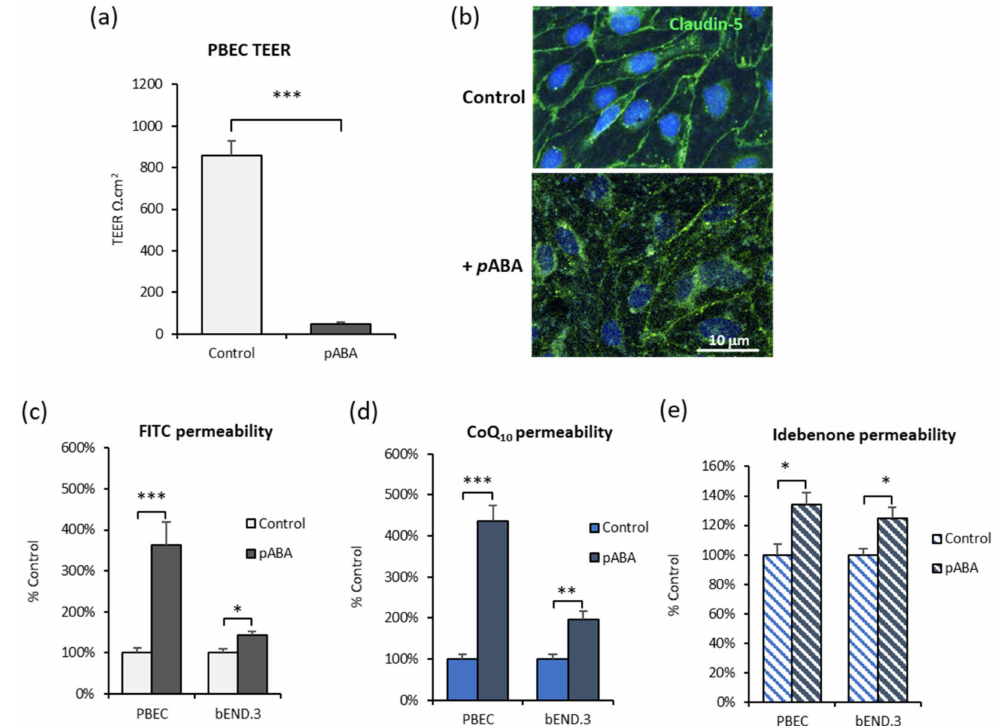
Figure 4. E ff ect of p ABA on in vitro BBB characteristics. BBB tight junction integrity after 5 days with p ABA (1 mM) treatment is compromised. ( a ) PBEC transendothelial electrical resistance (TEER) declines; n = 6. ( b ) Confocal microscopy staining for claudin-5 tight junction protein in PBEC cells on Transwells. Upper panel is control, lower panel after 5 days with p ABA (1 mM), shows reduced membrane localization of claudin-5 (40 × magnification) PBEC and bEnd.3 monolayers are more leaky to ( c ) FITC-40, ( d ) CoQ 10 and ( e ) idebenone. Values are mean ± SEM; PBEC n = 6, bEnd.3 n = 5–10; * p < 0.05, ** p < 0.01, *** p <